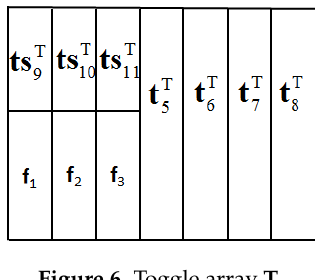
Figure 6. Toggle array T. Table 2. Toggle sequence t i , i = 5~8.